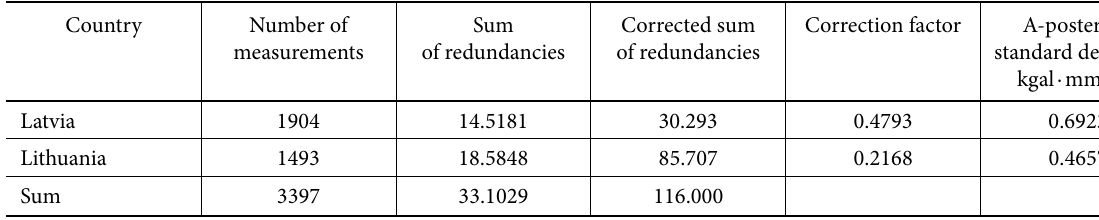
Table 8. Accuracy of levelling networks of Latvia and Lithuania Country